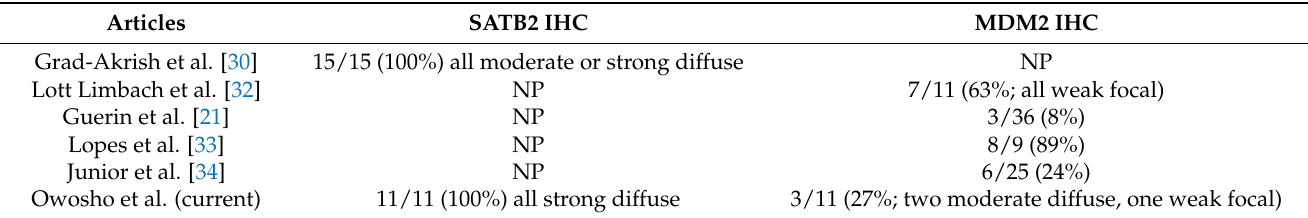
Table 3. Literature review of SATB2 and MDM2 in craniofacial and jaw